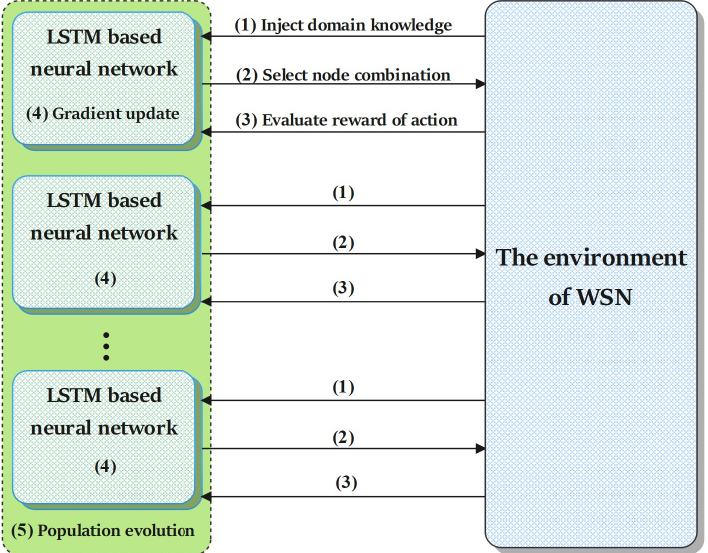
Figure 2. The framework of the domain knowledge-based ERL algorithm. Please note that the same serial number represents the same